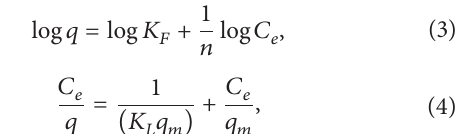
Figure 12(a) for basic orange dye and Figure 12(b) for methyl violet dye is employed to evaluate the intercept 𝐾 𝐹 and the slope 1/𝑛 . The values of 𝐾 𝐹 and 𝑛 and the linear correlation ( 𝑅 2 ) of Freundlich isotherm are given in Table 2 for basic orange dye and Table 3 for methyl violet dye. Figures 13(a) and 13(b) for basic orange and methyl violet dyes, respectively, illustrate Langmuir isotherm plot for experimental data ( 𝐶 𝑒 versus 𝐶 𝑒 /𝑞 ). The values of 𝑞 𝑚 , intercept 𝐾 𝐿 , and the linear correlation ( 𝑅 2 ) of Langmuir isotherm are given in Table 4 for basic orange dye and Table 5 for methyl violet